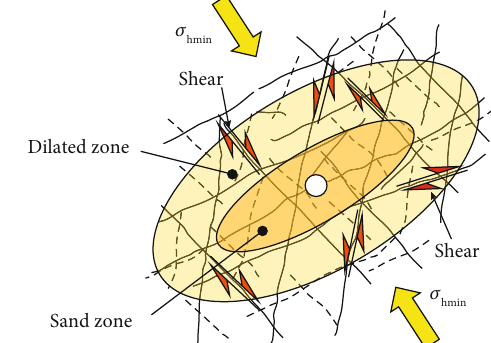
Figure 27: Evolution of the HFN geometry.